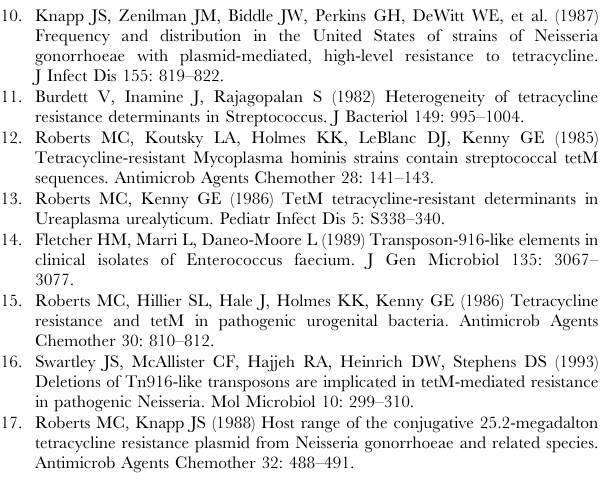
Figure S1 Alignment of the region between the zeta_1 and ngoSK11390 of the genetic load region of the neisserial conjugative plasmids. Depicted are the conjugative plasmid with the American type tetM determinant (A), the Dutch tetM determinant (D) and the plasmid without a tetM determinant (C). The different genes are indicated with different colors. Arrows above the genes indicate the orientation of the